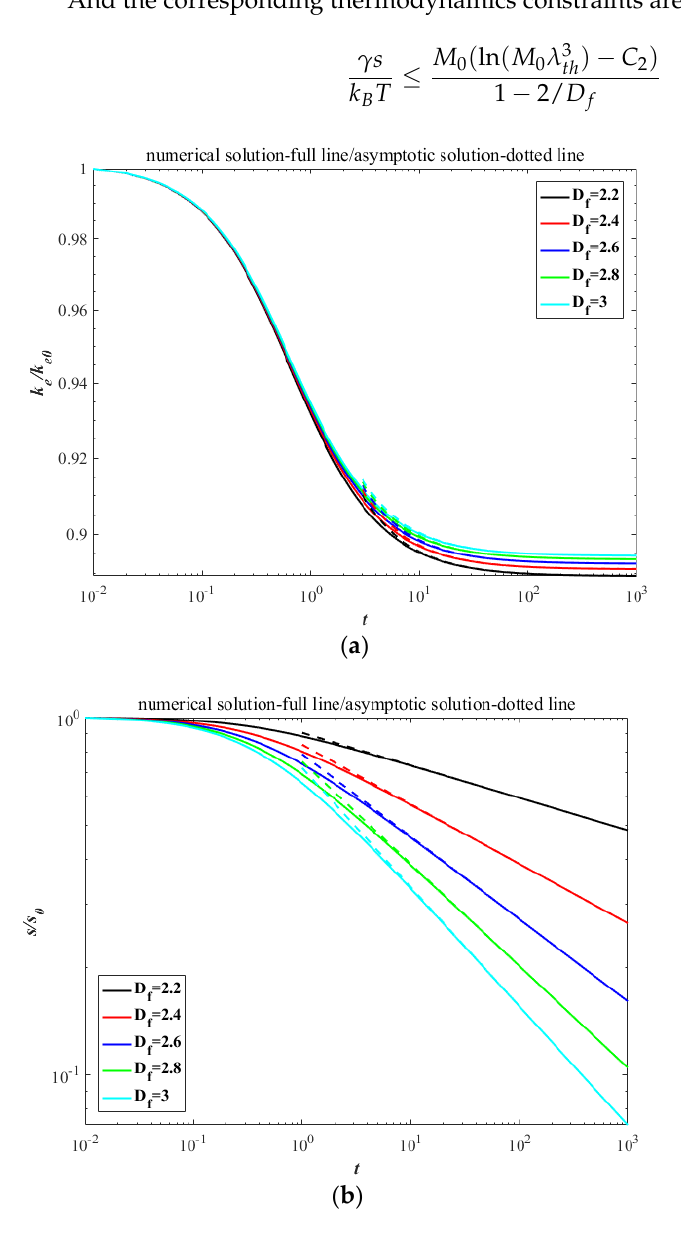
Figure 3. The decay with time between numerical solutions and asymptotic solutions in the contin- uum regime: ( a ) kinetic energy; ( b ) surface area.